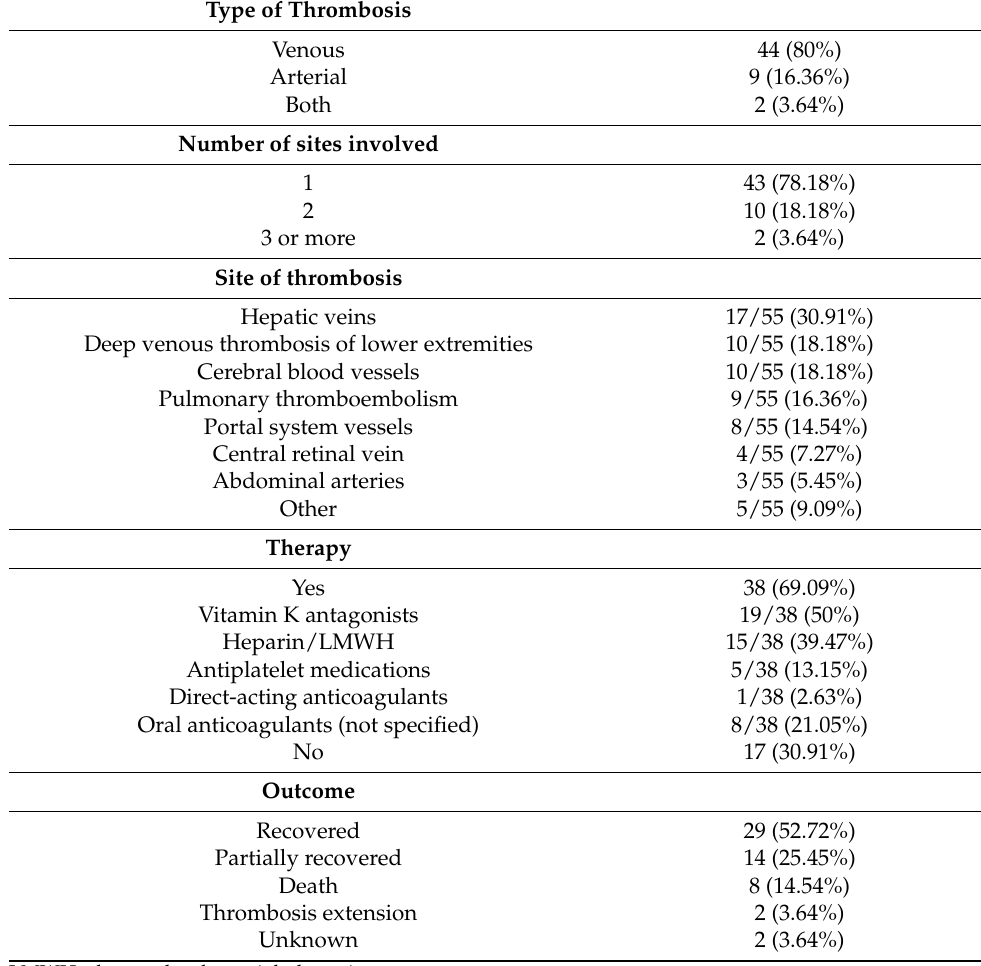
Table 2. Thrombosis characteristics, treatment and patients’